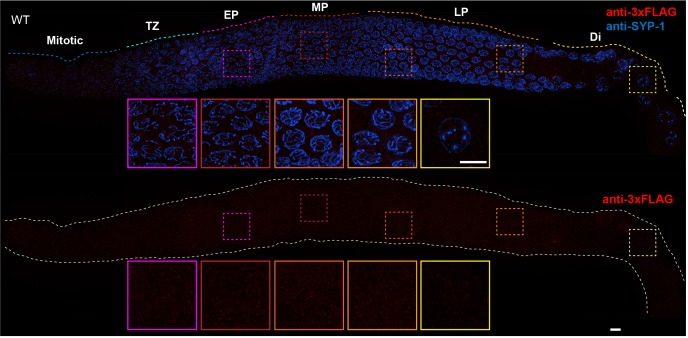
Absence of nonspecific staining with anti-FLAG antibodies in the C. elegans germline.Projection images showing C. elegans germline immunostained with anti-3xFLAG epitope antibody (red) and anti-SYP-1 antibody (indicating synaptonemal complex (SC), blue). Insets in each panel show representative nuclei (left to right) in early pachytene (EP), mid-pachytene (MP), late pachytene (LP) and diplotene (Di). Anti-FLAG antibody staining shows no obvious unspecific signal in the germline. Mitotic and TZ indicate Mitotic zone and Transition Zone, respectively. WT: wild-type. Scale bars, 5 µm.